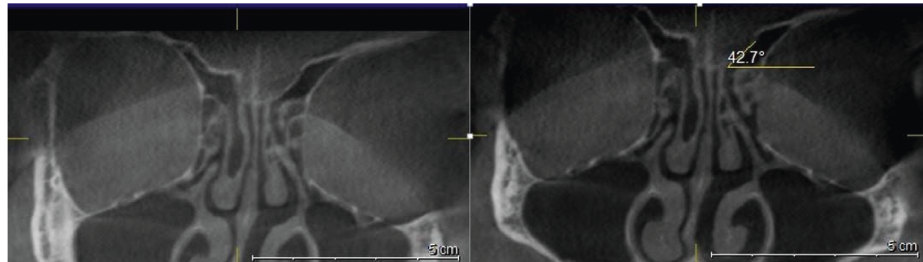
Figure 6: Coronal plan of CBCT demonstrating type III Gera classification on the left side.